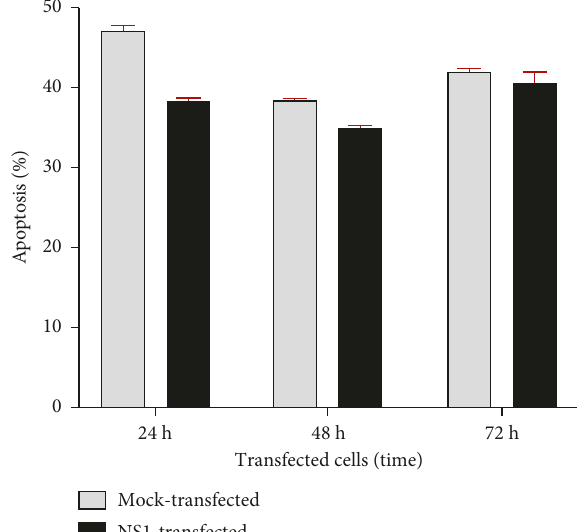
Figure 3: Percentage of apoptotic cells in mock- and NS1-transfected HEK-293T cells at 24hr, 48hr, and 72hr posttransfection was determined by flow cytometry of cells that stained double-positive for PE Annexin V and